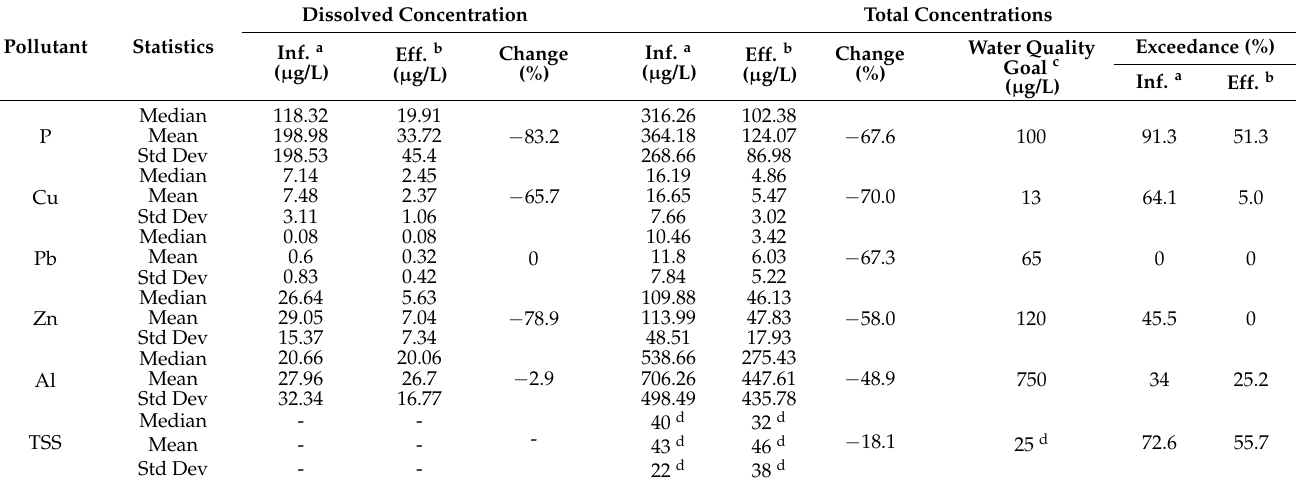
Table 2. Results of the dissolved and total concentrations of phosphorus and heavy metals.